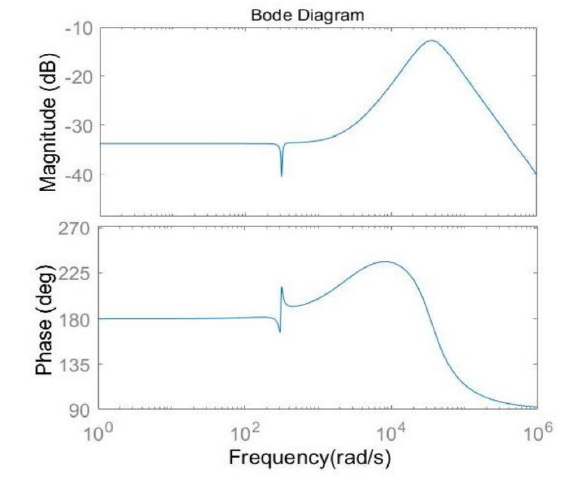
Fig. 8. Bode diagram of voltage disturbance transfer